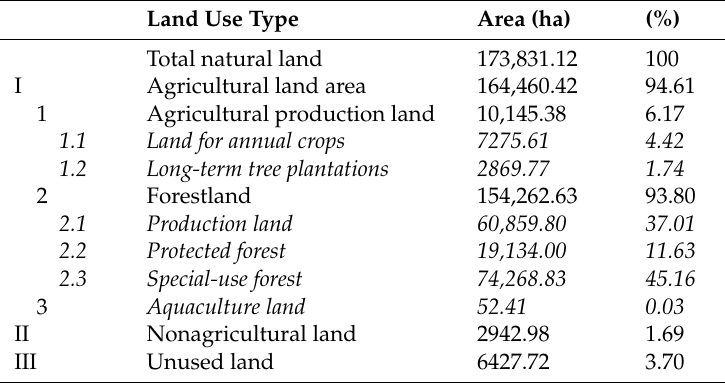
Table 2. Current land use of Con Cuong District, Nghe An Province,